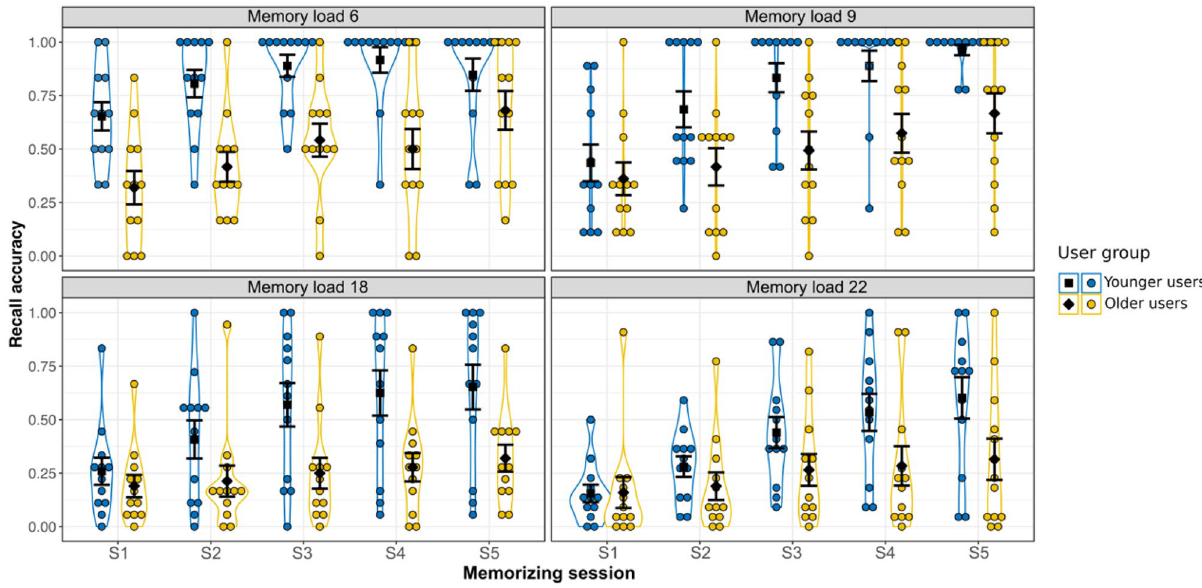
Figure 4. Mean recall accuracy as a function of memory load, memorizing session and user group. Black squares and diamonds represent mean recall accuracy in the younger and older users, receptively, for the different memory loads following every memorizing session. Jittered dots in blue are recall accuracy for every younger user and the dots in yellow are individual recall accuracy of older users. Error bars indicate the standard error of the